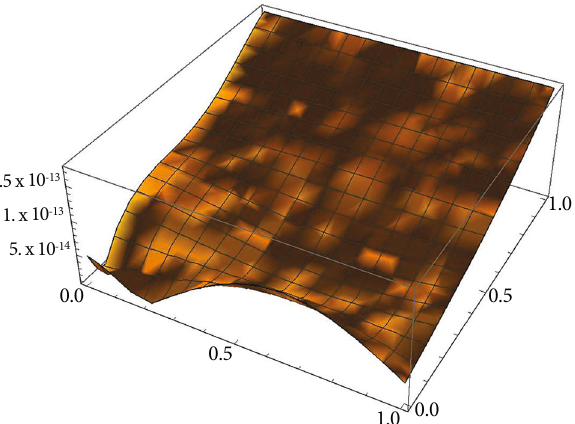
Figure 12: Absolute error for Example 8.